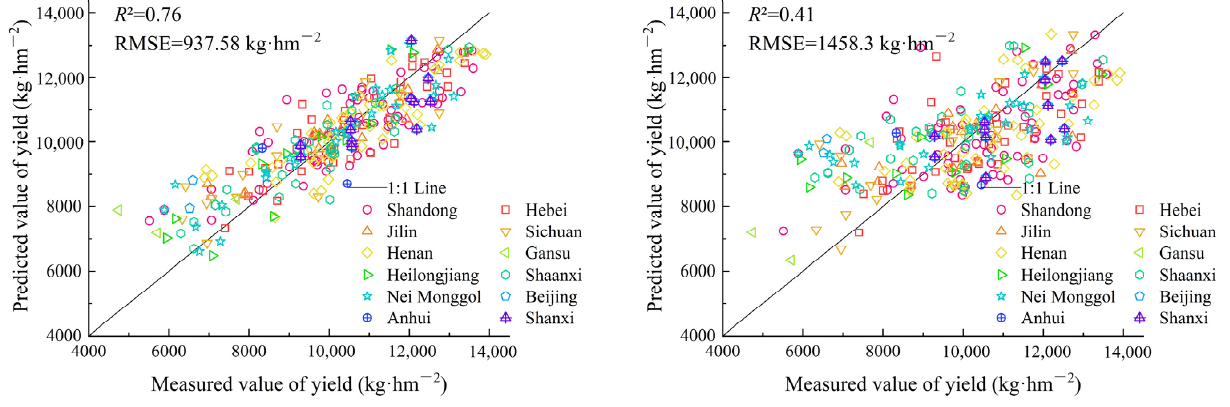
Figure 8. Regression model for summer maize yield.